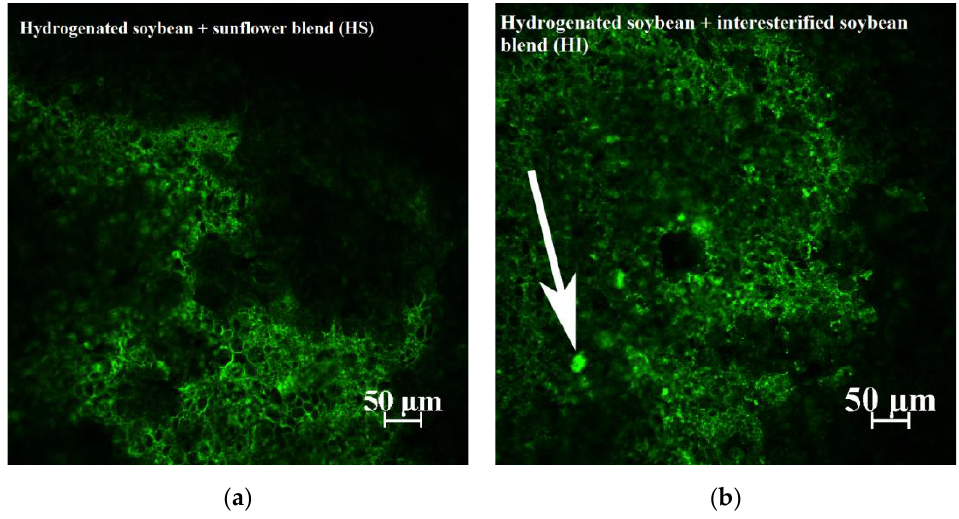
Figure 3. Confocal images of crackers made with either ( a ) hydrogenated soybean fat + interesterified soybean fat (HI, SFC = 32.0 %) or ( b ) hydrogenated soybean fat + sunflower oil (HS, SFC = 24.9 %).